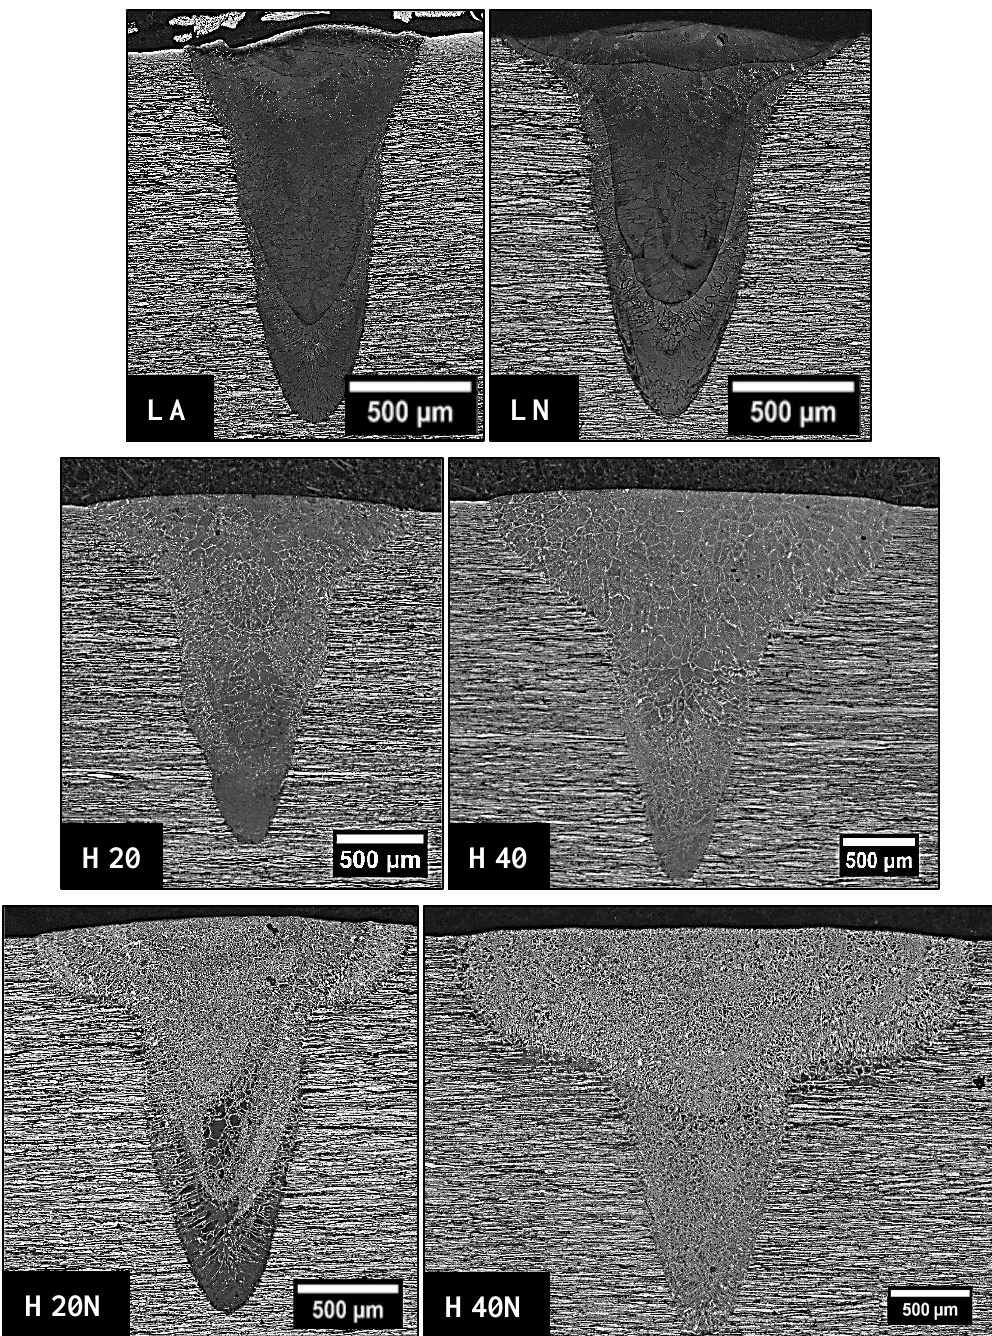
Figure 7. OM of weld bead cross sections. The %V of austenite in FZ increased from samples LA to H40N due to higher values of heat input and nitrogen addition.